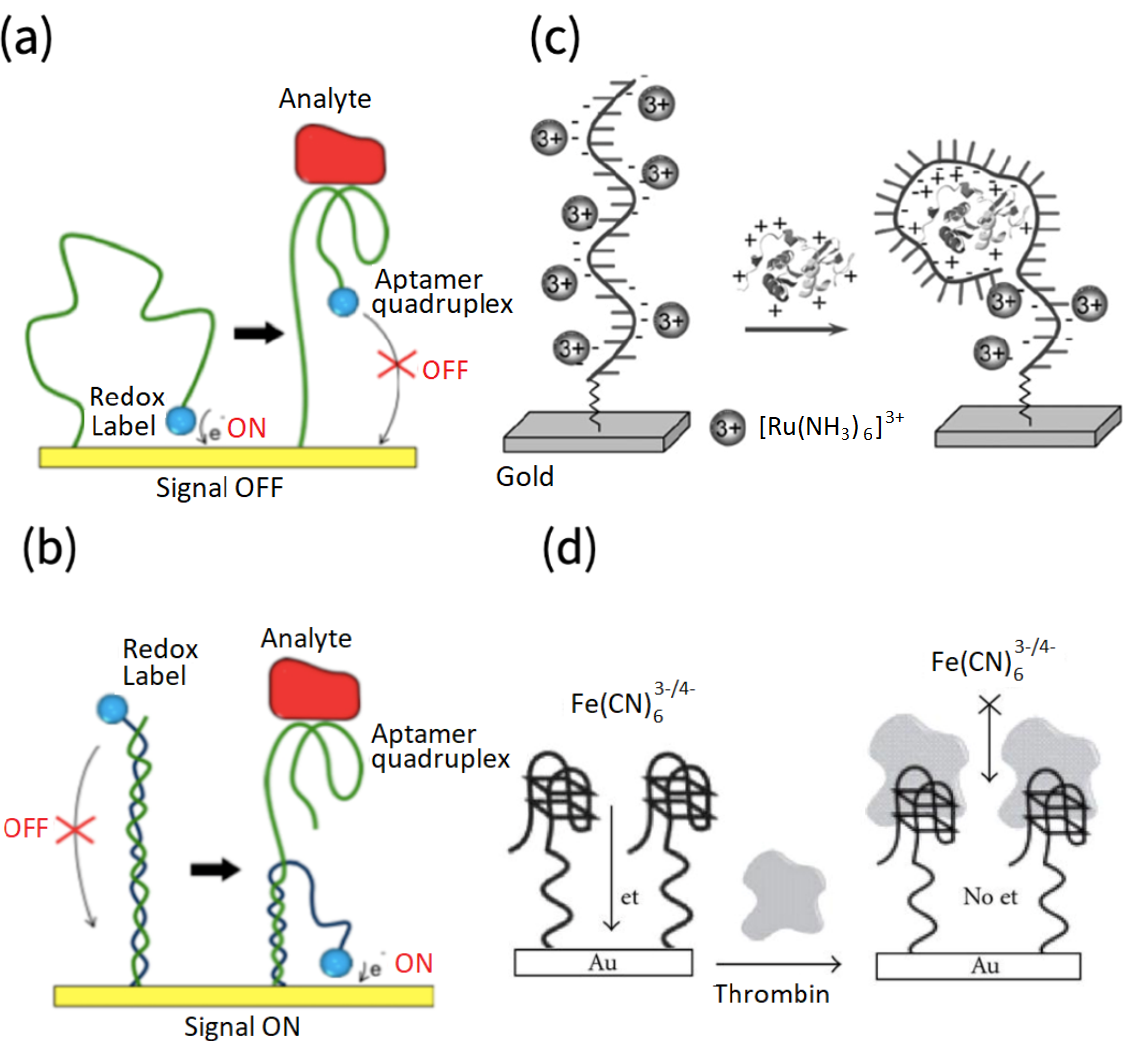
Figure 2. Conformational changes in aptamer structure due to binding to the analyte. When the electrochemically active probe is attached to the aptamer, binding-induced conformational changes bring the probe either farther ( a ) or closer ( b ) to the electrode surface, resulting in signal off or signal on, respectively. Adapted from [39]. In ( c ), binding of the analyte to aptamer reduces the electrostatic interaction between [Ru(NH 3 ) 6 ] 3+ and aptamer, which results in a decrease in the reduction peak. Adapted from [40]. In ( d ), the binding of the analyte to the aptamer hinders the access of the solution-based redox probe to the electrode surface. Adapted from [41].